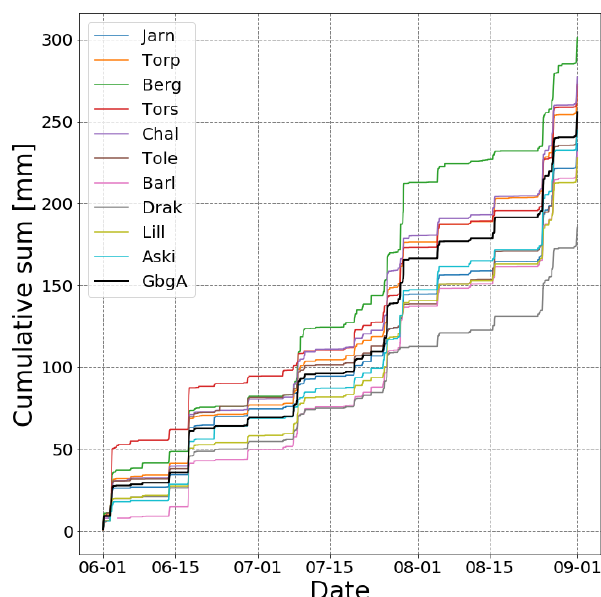
Figure 10. Comparison of the SMHI gauge and the City network gauges. The figure shows the cumulative rainfall sum in each gauge over the study